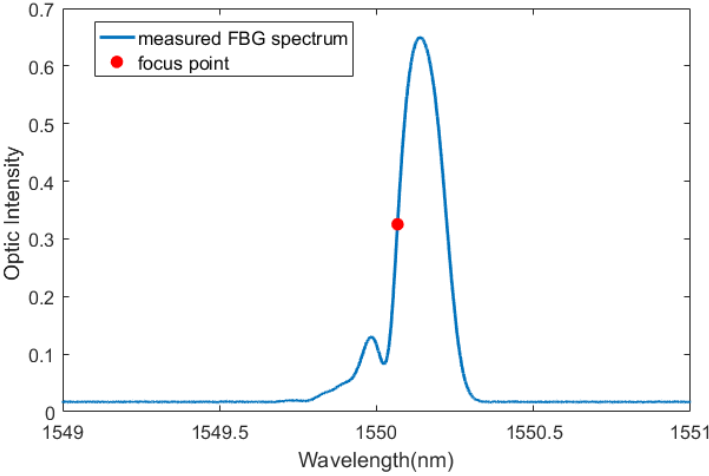
Figure 11. The FBG spectrum and the focus point for strain measurement.